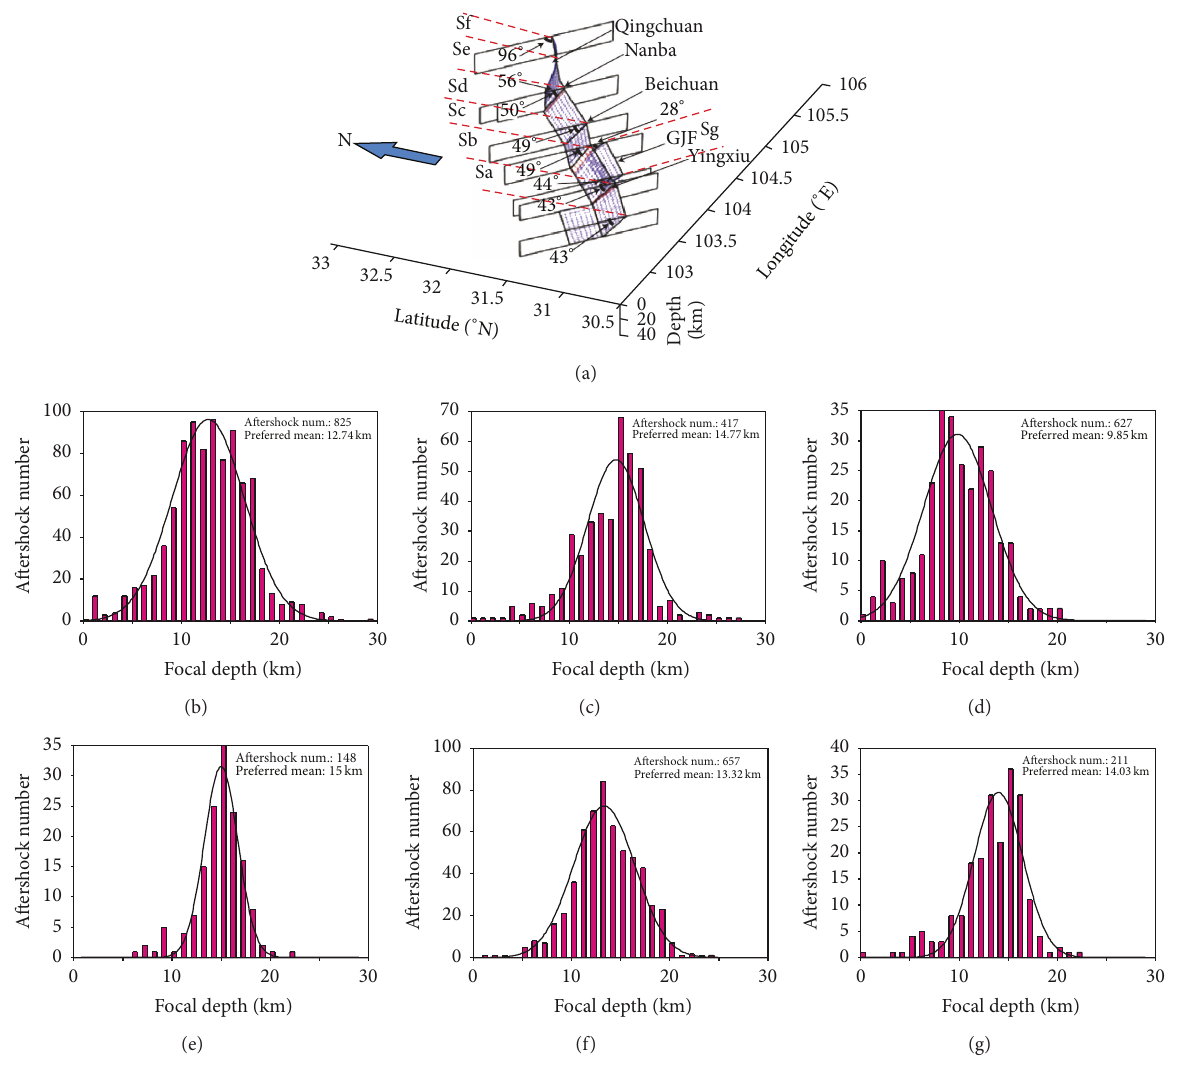
Figure 4: Fault model and focal depth of the seismogenic zone along the central Longmen Shan fault zone. (a) Fault geometry and segments viewed from the southwest, at 45 ∘ elevation angle (modified from [6]). Borders of fault segmentation are shown in Figure 1. (b)–(g) are statistic results of focal depth for segments Sa–Sf, respectively, according to the relocated aftershocks [28]. Statistical samples of each segment are aftershocks enclosed by segment borders, as shown in Figure 1. Black solid lines are regression curves of Gaussian distribution, which pass the Shapiro-Wilk Normality test. The value of preferred mean is estimated from the regression result. Table 1: Parameters of fault model and accumulation moment rate in the seismogenic subsegments. Seismogenic